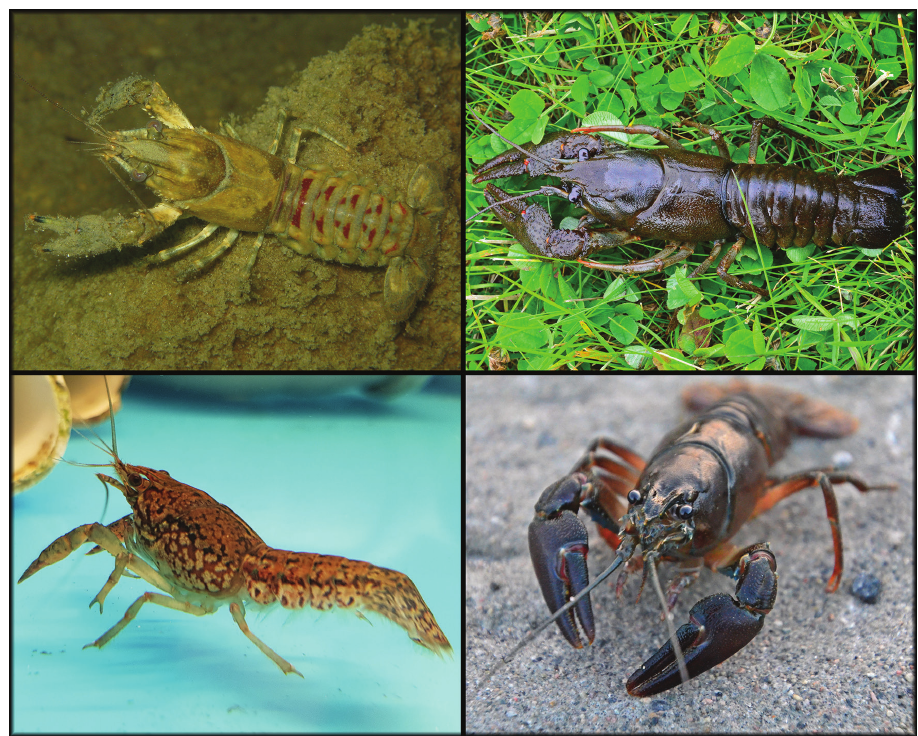
Figure 1. Crayfish species searched for by means of eDNA. Species clockwise from top left: Faxonius limosus , Astacus astacus , Pacifastacus leniusculus , Procambarus virginalis . Photos taken by A. Petrusek (Fl) and J. Rusch (Aa, Pl,